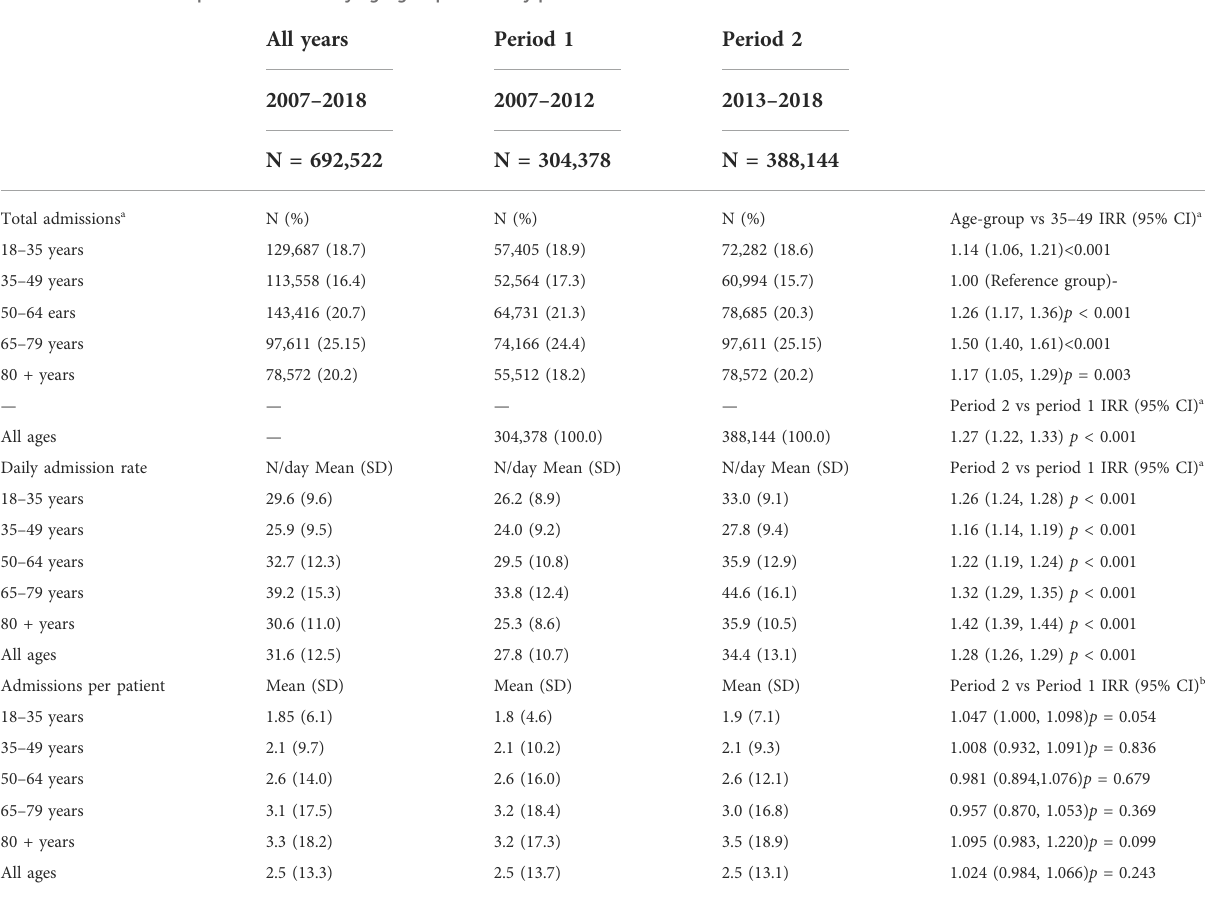
TABLE 1 Number of hospital admissions by age-group and study period. All